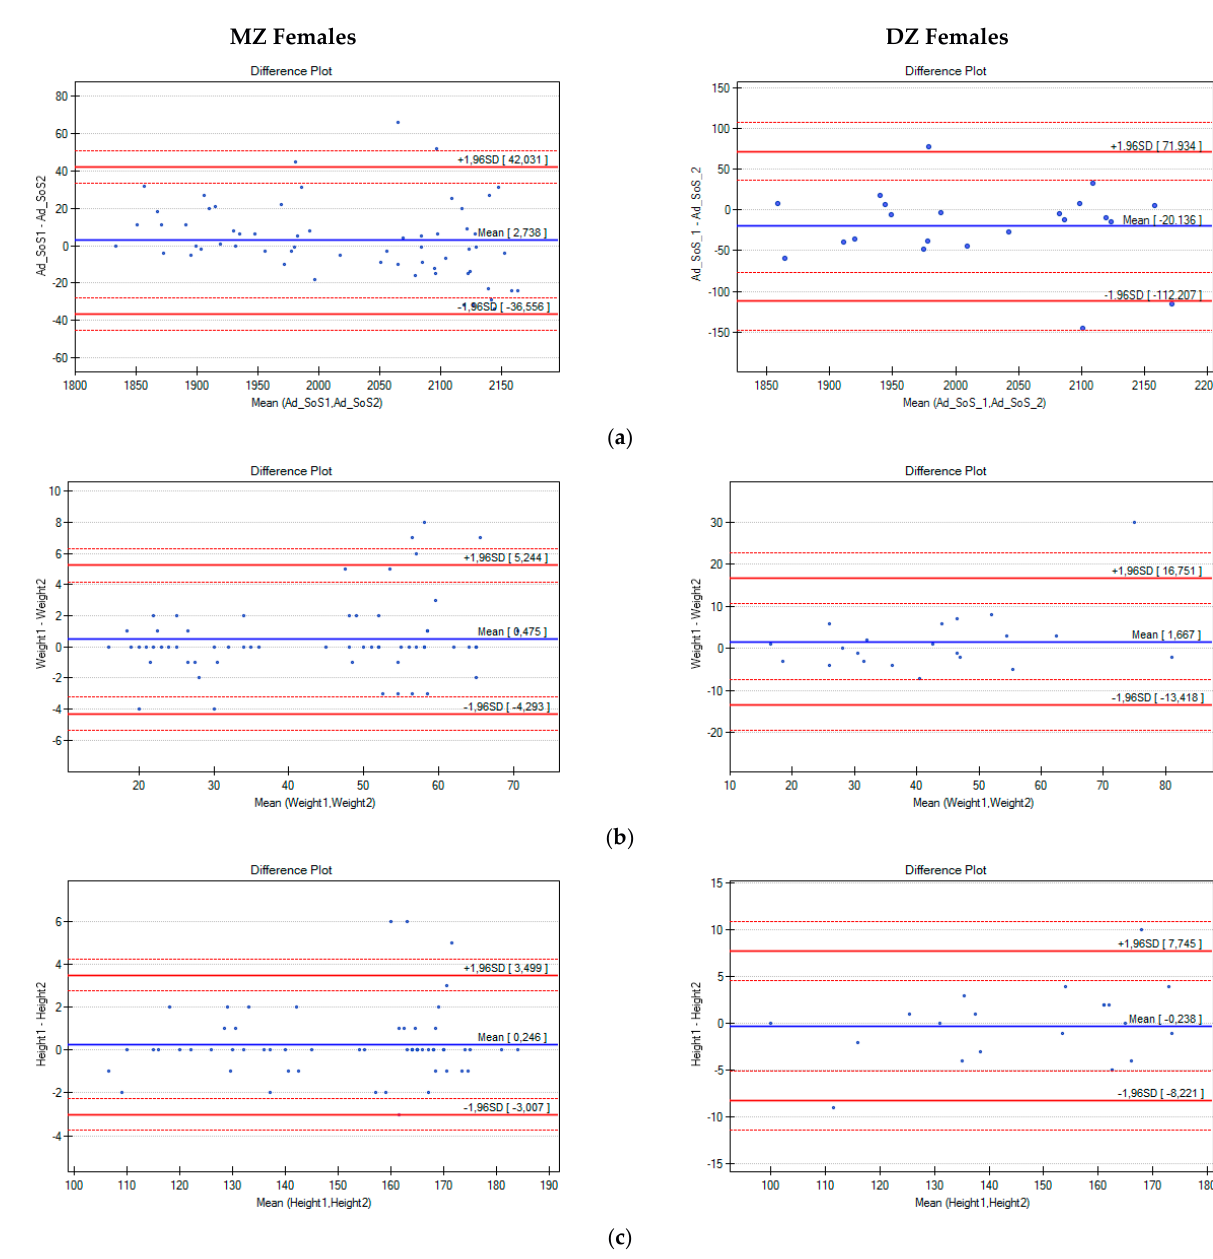
Figure 2. Bland–Altman plots for Ad-SoS ( a ), weight ( b ), and height ( c ) differences in pairs of female twins (the x-axis represents the mean values of the parameters in twin pairs, and the y-axis represents the intrapair differences between Twin A and Twin B).